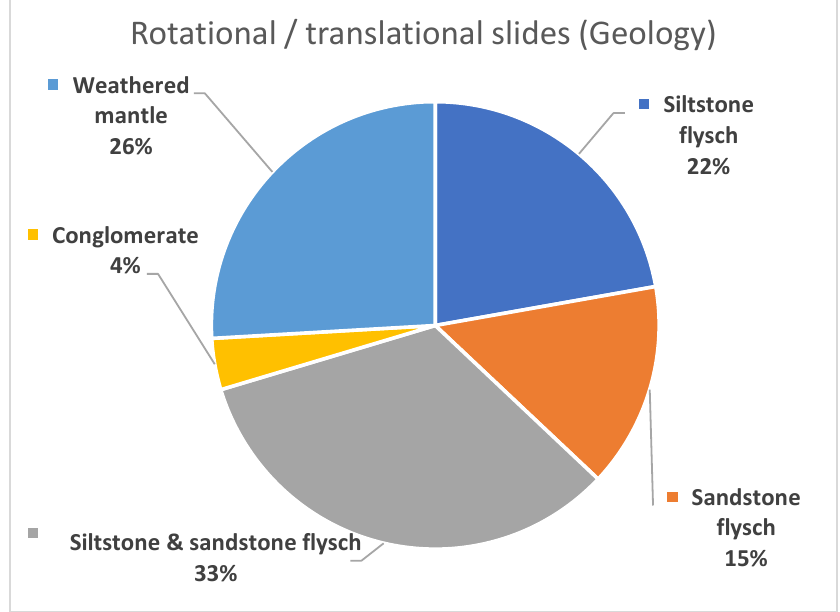
Figure 6. Different lithology types affected by rotational and translational slides.